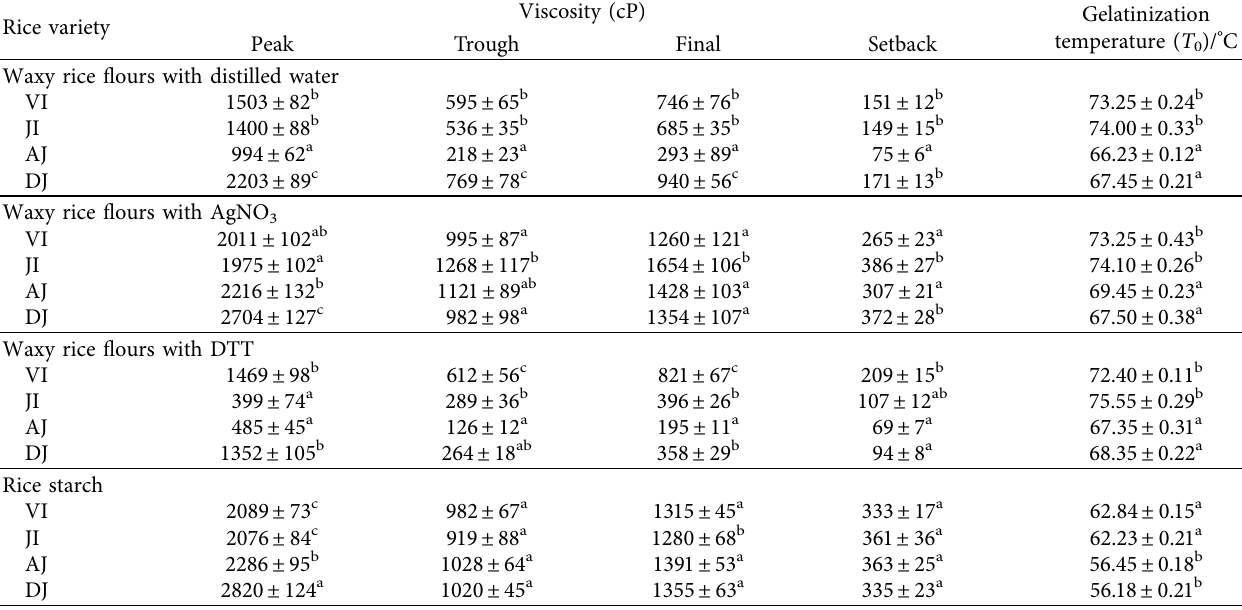
Table 2: Pasting properties gelatinization temperatures of waxy rice flours and starches ∗ .